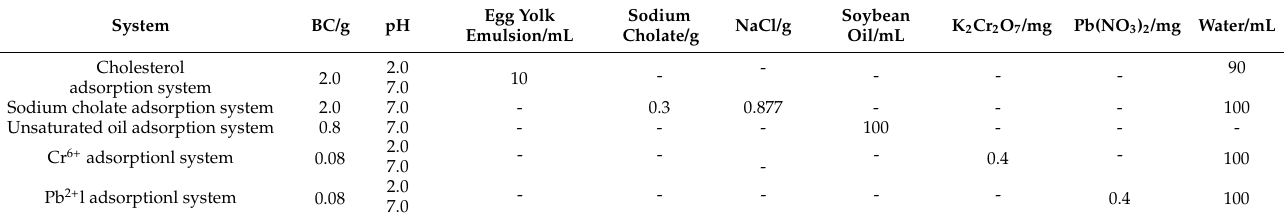
Table 1. The composition of in vitro adsorption experiment (100